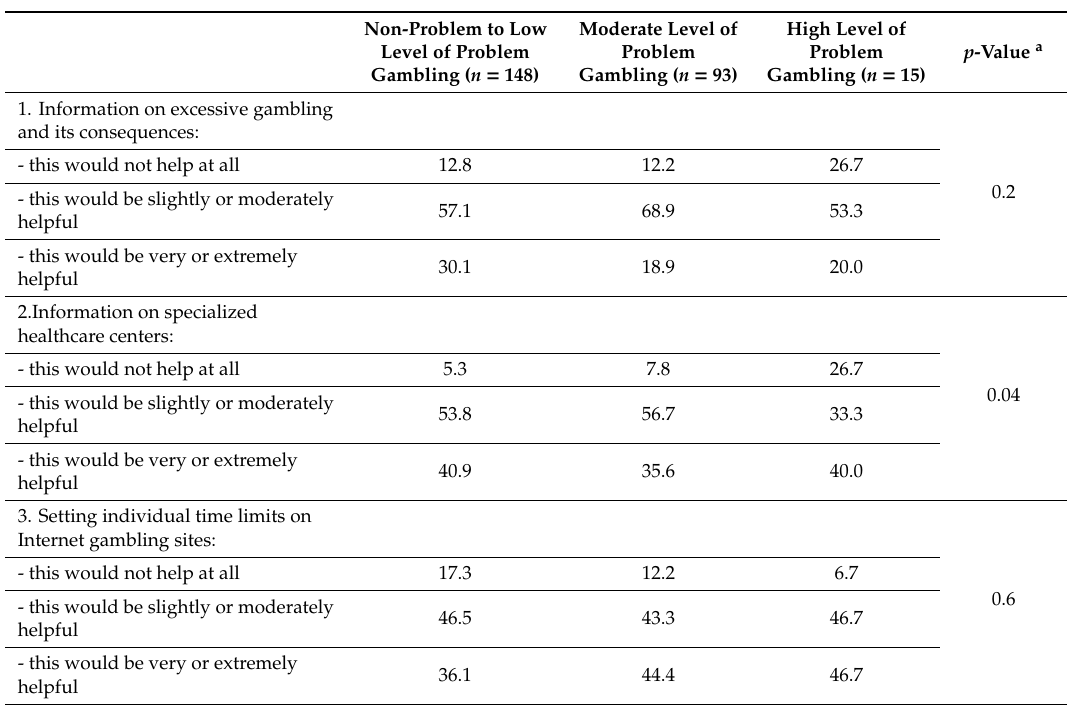
Table 4. Harm reduction items according to the Problem Gambling Severity Index (PGSI). Data are expressed as a